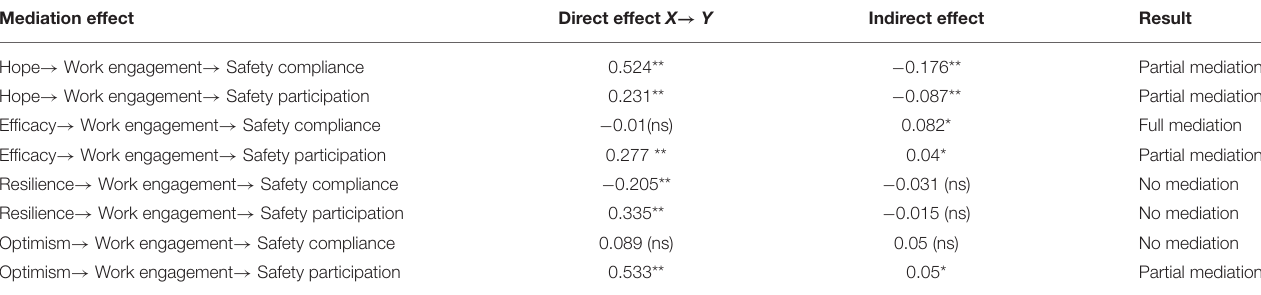
TABLE 7 | Standard direct and indirect effects for the mediation